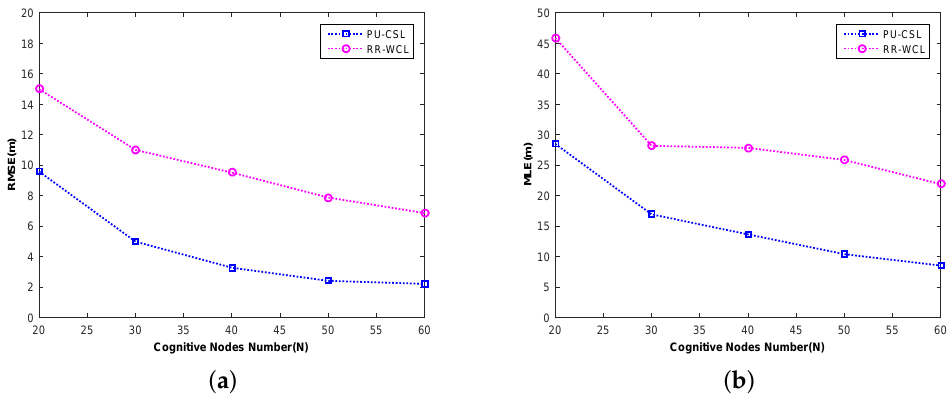
Figure 6. The localization performance of the PU-CSL and RR-WCL algorithms. ( a ) The root mean square error curve with the change of cognitive node number; ( b ) The maximum location error curve with the change of cognitive node